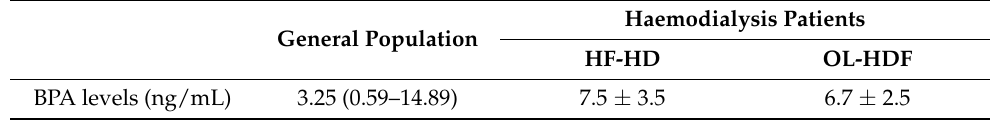
Table 2. BPA serum levels in the general population and in haemodialysis patients (with the differ- ent